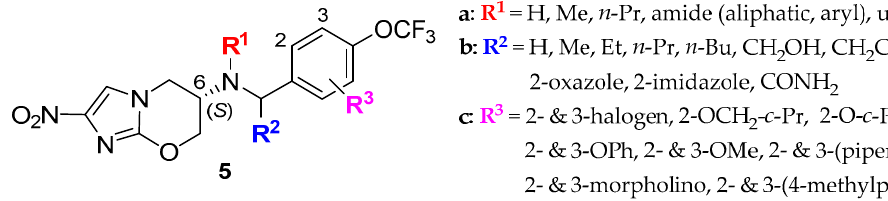
Figure 2. 6-( S )-Aminopretomanid analogues 5 with variations at R 1 , R 2 , and R 3 .